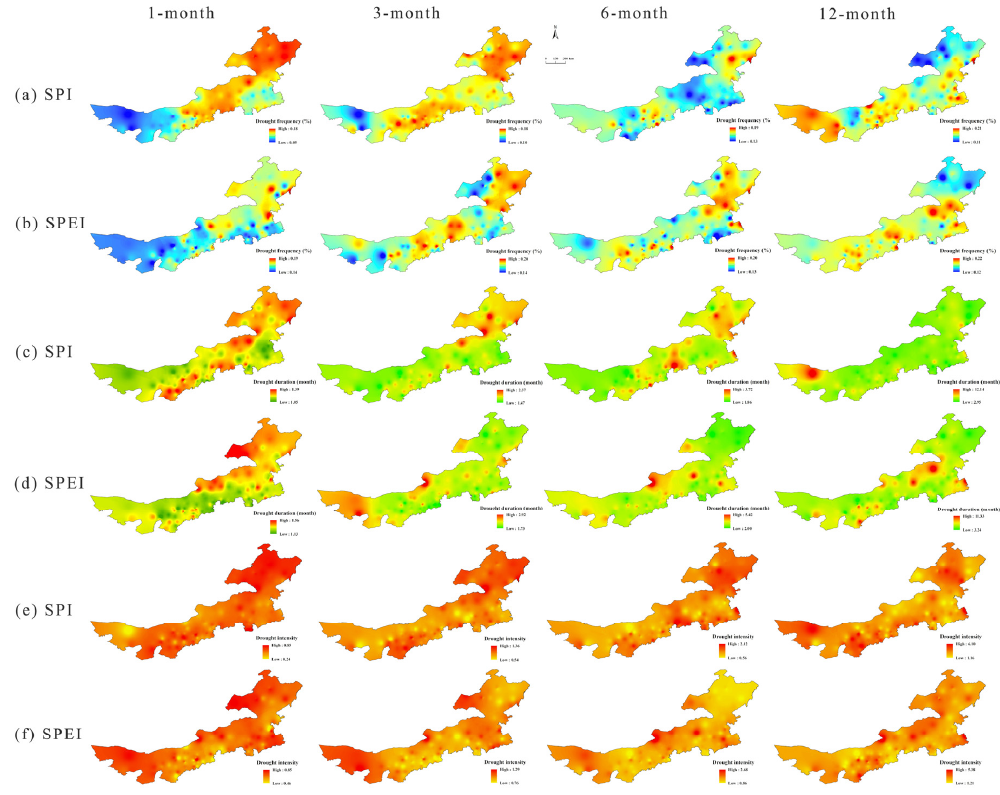
Figure 5. Spatial distribution of drought characteristics at 1-, 3-, 6-, and 12-month timescales in Inner Mongolia during 1981–2018. Drought frequency, ( a ) SPI and ( b ) SPEI; drought duration, ( c ) SPI and ( d ) SPEI; and drought intensity, ( e ) SPI and ( f ) SPEI.